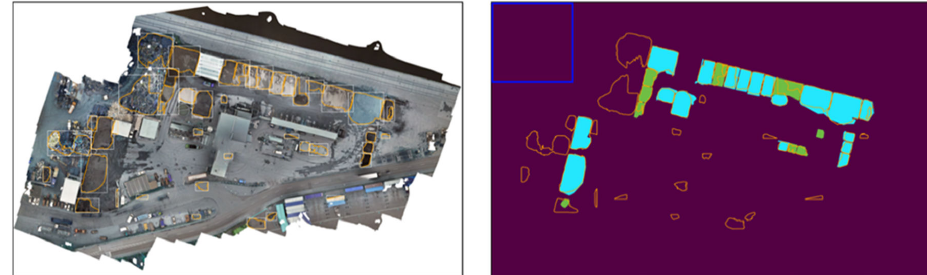
Figure 18. Results on Test Site C. Colors and shapes have the same meaning as on test site